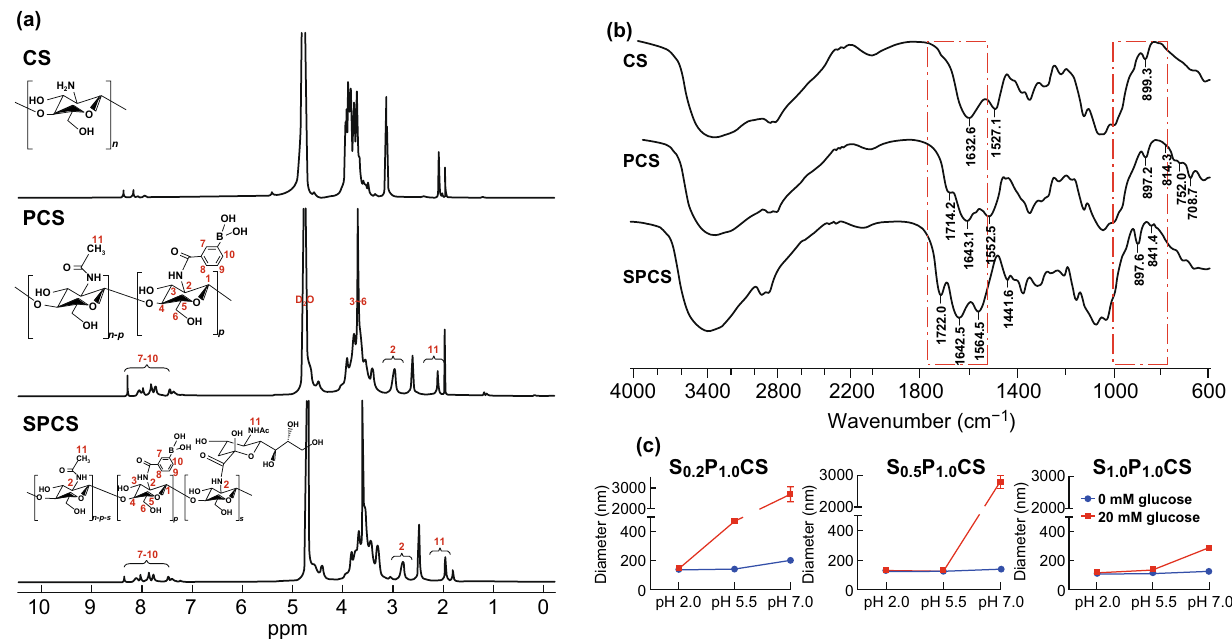
Figure 1 Structural characterization of various chitosan derivatives. 1 H NMR spectra a and FTIR spectra b of CS, PCS and SPCS. c Diameter variations of SPCS micelles at pH values of 2.0, 5.5 and 7.0, with the presence and absence of glucose (20 mM)